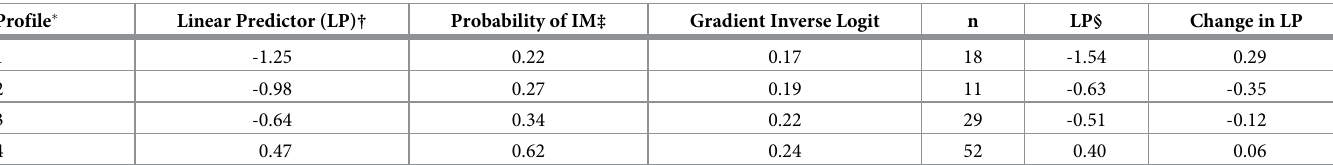
Table 8. Results of determining model using change in